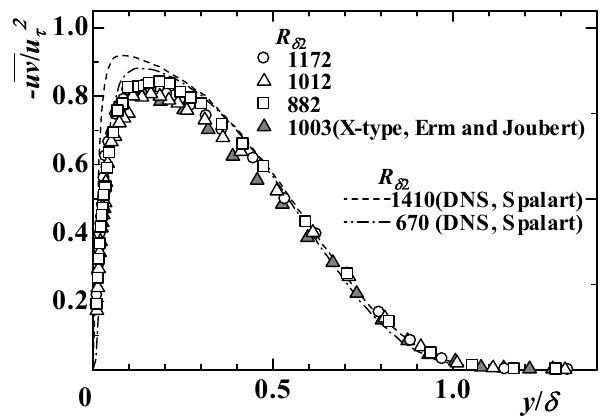
Fig. 17 Distributions of Reynolds stress